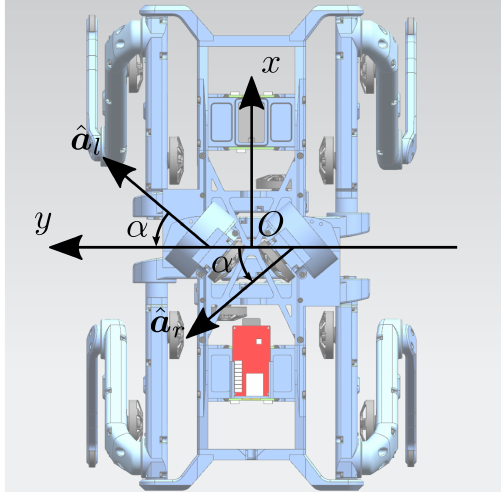
Figure 4. Top view of Solo12 with the proposed OCS. The x − and y − axes embody the forward and left directions of the robot base, respectively. The figure also illustrates the unit vectors ˆ a l and ˆ a r that represent the axes of rotation of the left flywheel and of the right one and α is the angle of incidence, defined in Section 3.2.